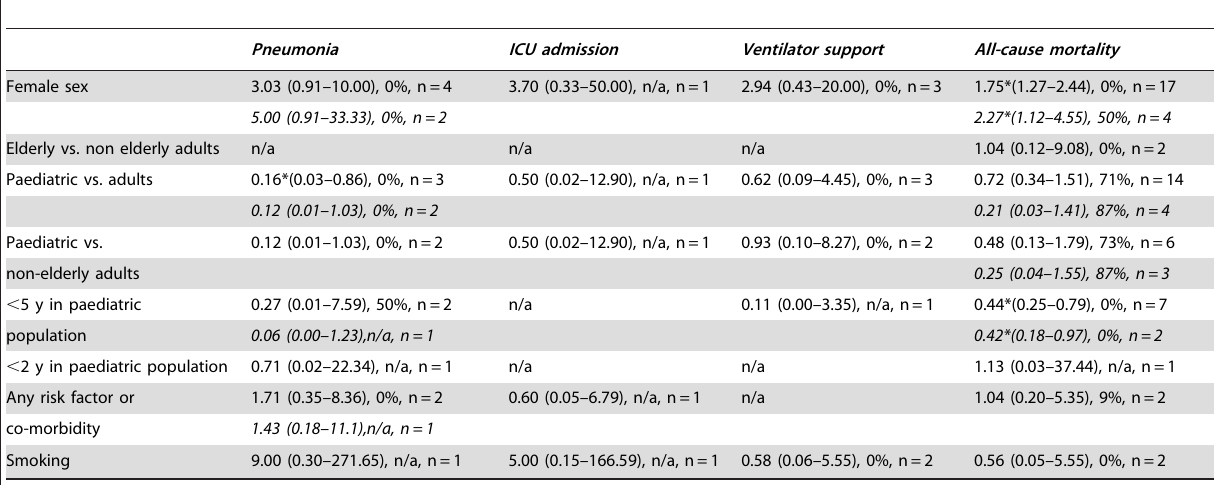
Figure 2. Forest plot comparing mortality in females as compared to males. doi:10.1371/journal.pone.0089697.g002 Table 1. Summary estimates of risk-factor–outcome comparisons during H5N1 Avian influenza with odds ratio (95% confidence interval), I 2 , and number of included studies (n); where applicable, sensitivity analysis in italic